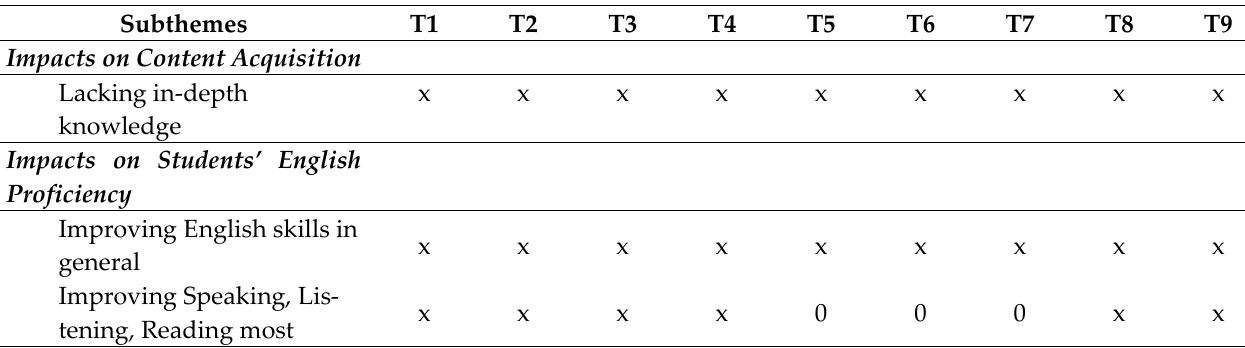
Table 1. Perceived Impacts of EMI on